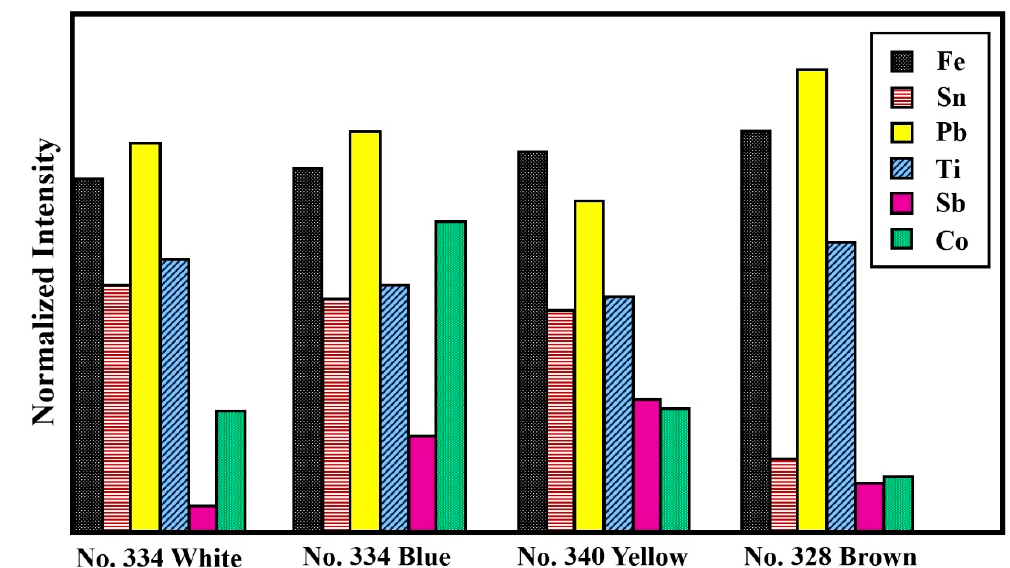
Figure 7. TOF-SIMS analysis results of Type A and B tiles, showing the element content of the different pigments, surrounded by glaze matrix.